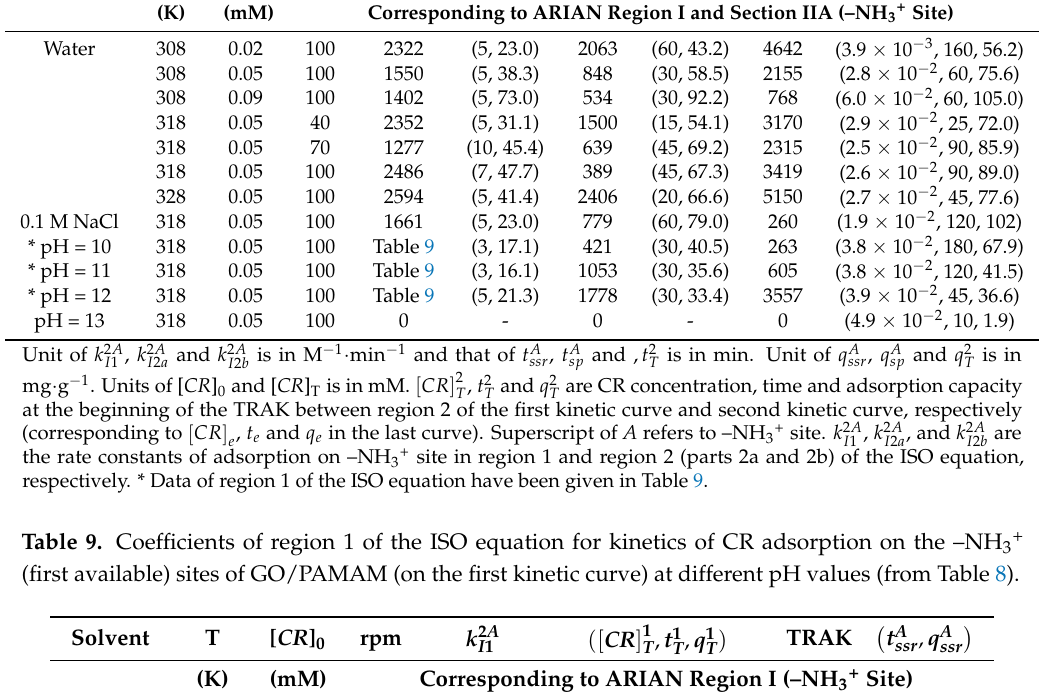
Table 8. Coefficients of region 1 and region 2 (parts 2a and 2b) of the ISO equation for kinetics of CR adsorption on the –NH 3+ (first available) sites of GO/PAMAM (on the first kinetic curve) at 308–328 K. Solvent